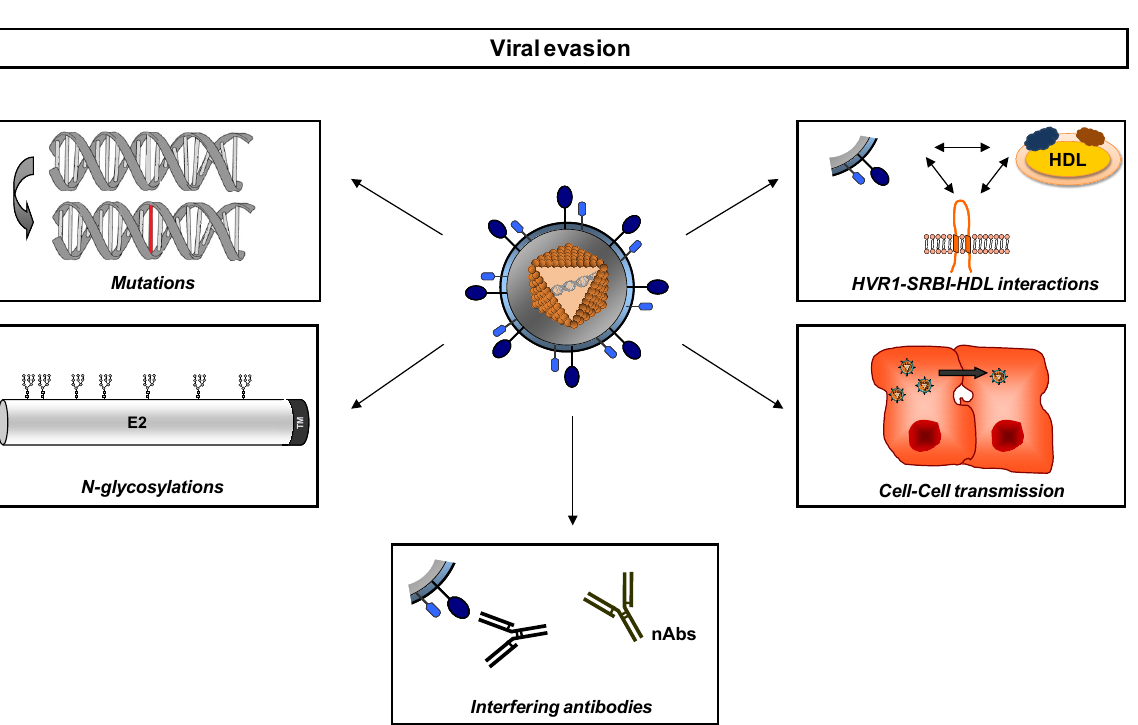
Figure 1. Strategies of viral evasion during Hepatitis C virus (HCV) infection. HCV has adapted multiple mechanisms to escape host immunity. The low-fidelity HCV RNA polymerase NS5B introduces point mutations to generate a genetic diversity within the quasispecies in an infected host. Many of the viable variants cluster in high-variability regions (e.g., HVR1) of the glycoprotein sequences, which can contribute to differential binding and usage of HDL and SR-BI of different variants, providing flexibility for adaptation against host humoral immunity. Glycosylation sites conceal important functional domains of E2 by forming a glycan shield that reduces the viral immunogenicity and the access of the epitopes to nAbs (reviewed in [68]). Additionally, the action of nAbs may also be disturbed by the presence of interfering antibodies. Another way of escaping neutralizing antibodies is by avoiding the circulation altogether, by dissemination via cell- to-cell transmission. HDL: High Density Lipoprotein ; HVR1: Hypervariable Region 1; nAbs: neutralizing